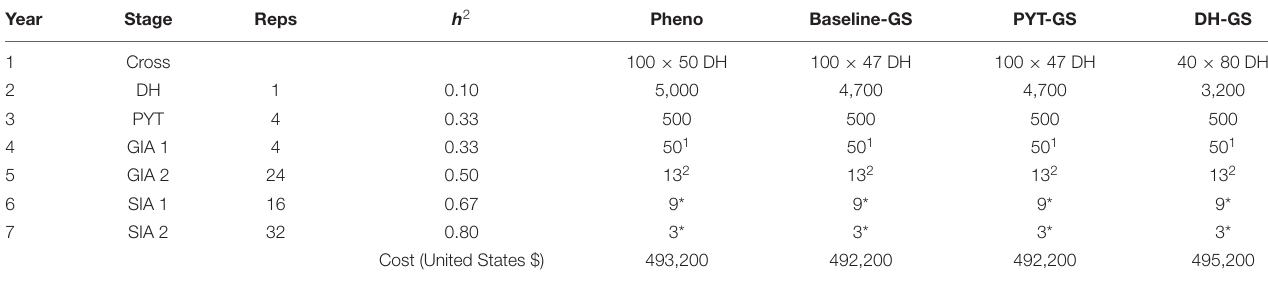
TABLE 1 | Summary of per stage parameters and annual operational costs for four ‘medium’ breeding